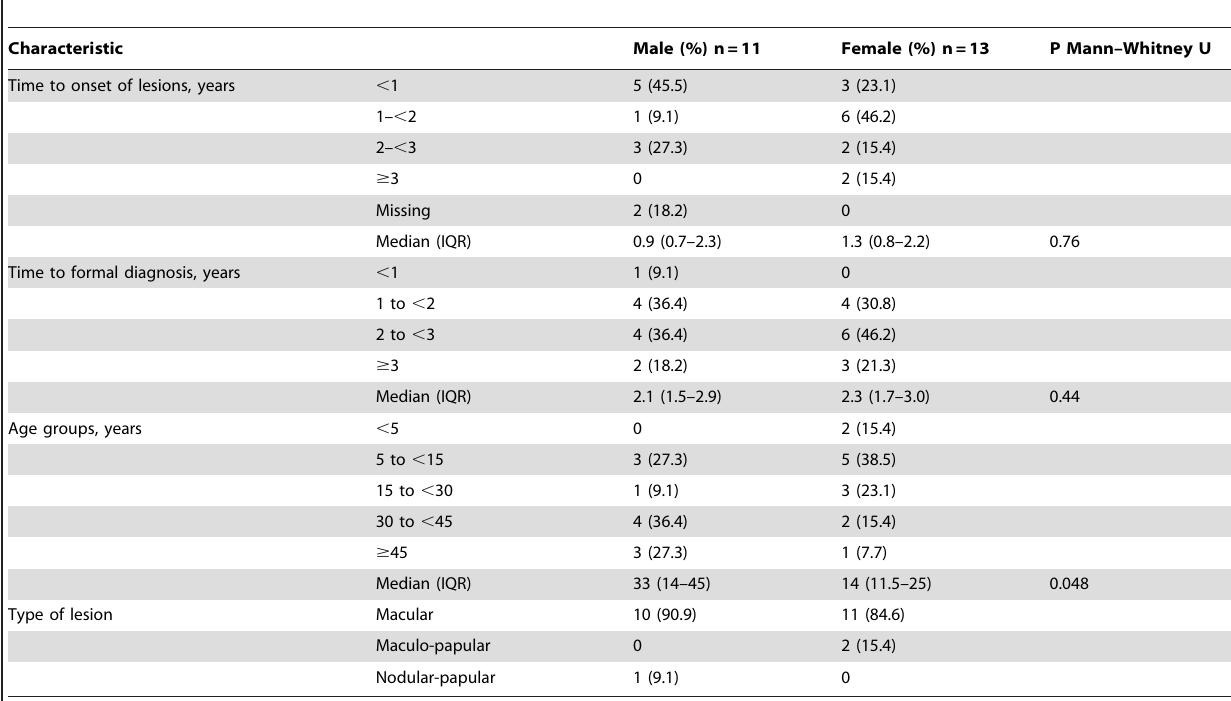
Table 1. Characteristics of patients with confirmed post-Ambisome PKDL stratified by sex (N= 24).